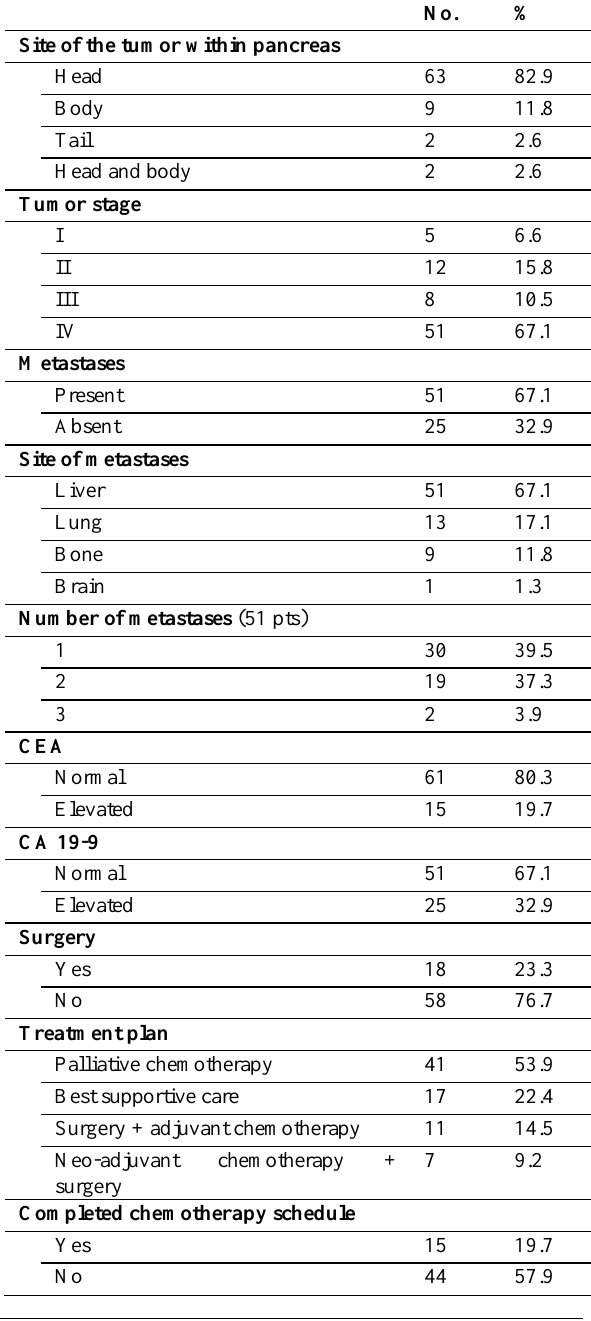
Table 2: Tumor characteristics and treatment (76 pts)